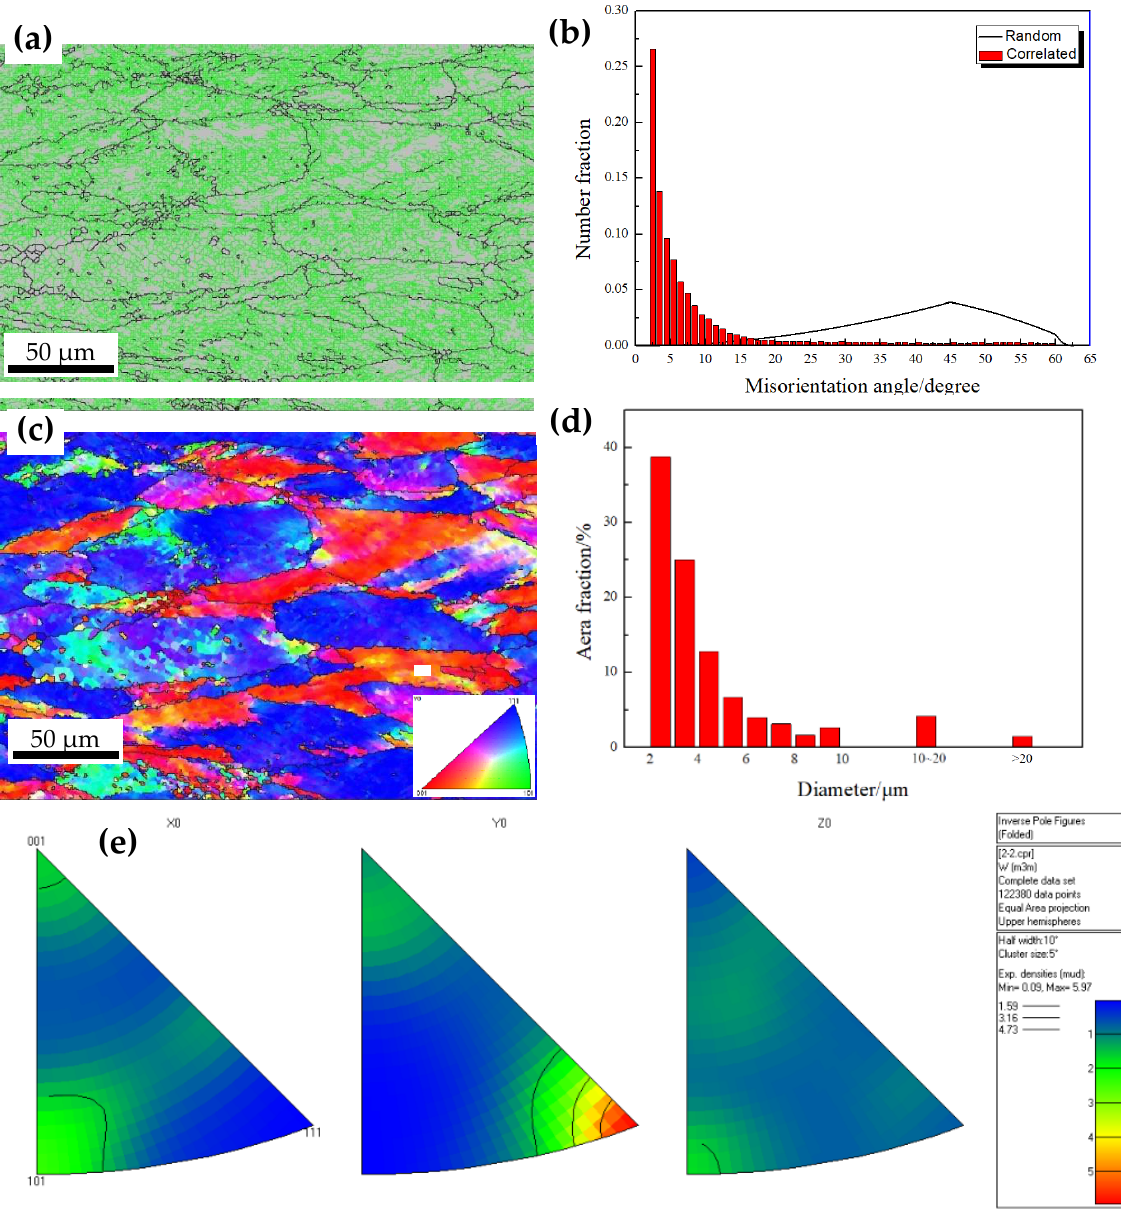
Figure 5. EBSD results of the HERFed WTC material. ( a ) Distribution of grain – subgrain boundary. ( b ) Misorientation distribution. ( c ) IPF mapping in the forging direction. ( d ) Grain size distribution. ( e ) Inverse pole figures.